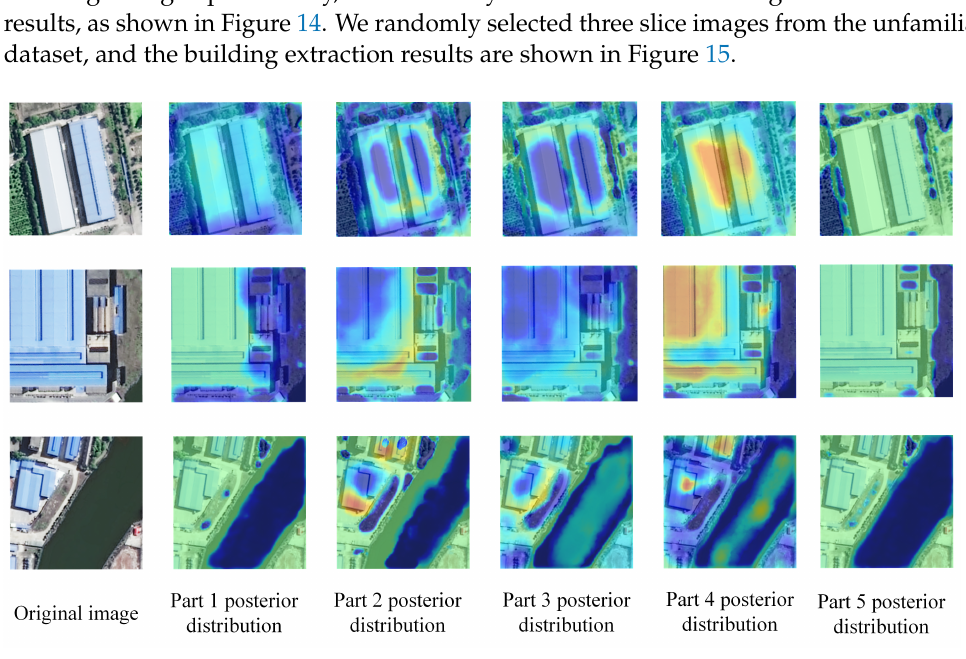
Figure 14. More visualization results about